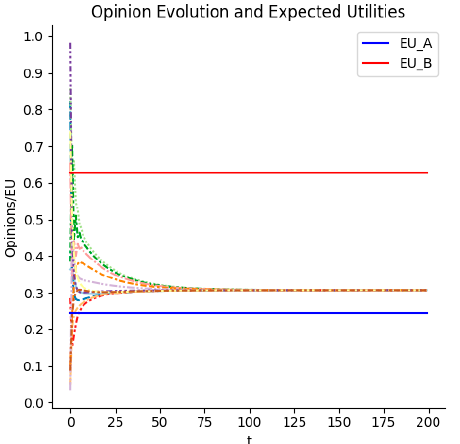
Figure 2. The opinion evolution process and expected utilities of firms A and B.